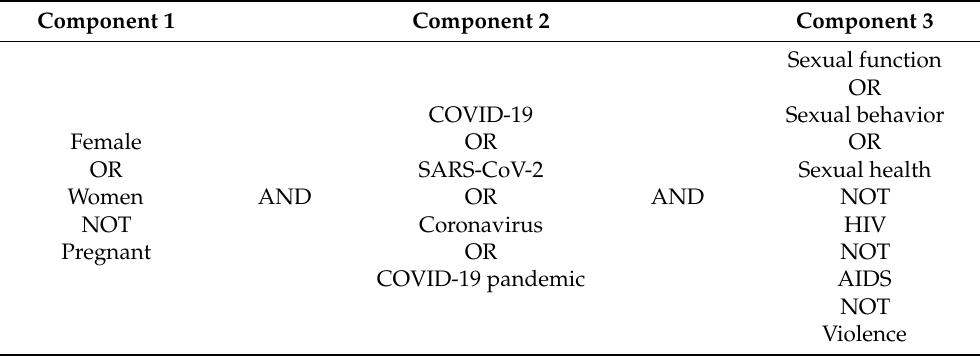
Table 1. The terms were used.